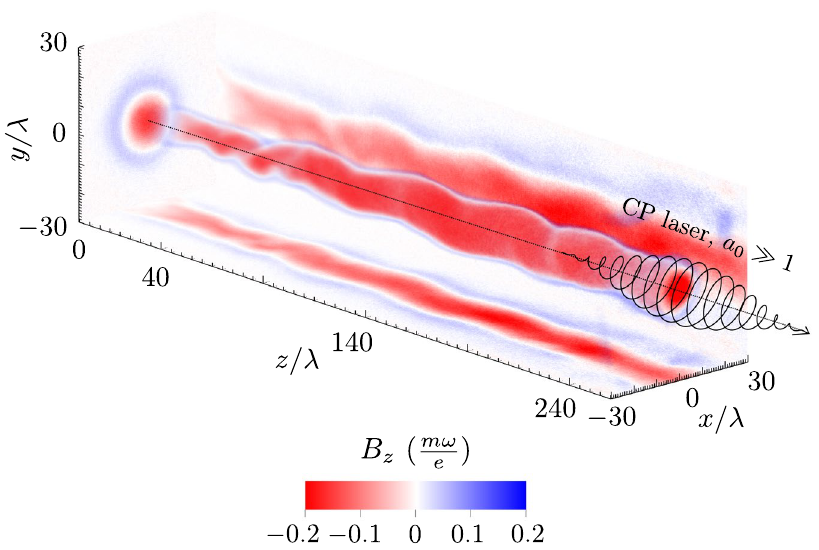
Figure 1. Schematic of intense magnetic wakefield generation by a relativistic laser in plasma. Magnetic fields generated by a relativistic right-hand circularly polarized relativistic laser pulse propagating in plasma. Axial component shown for relativistically underdense plasma where n e / n c 11.7 T , where T is a laser period. Magnetic field given in units m ω τ fwhm =